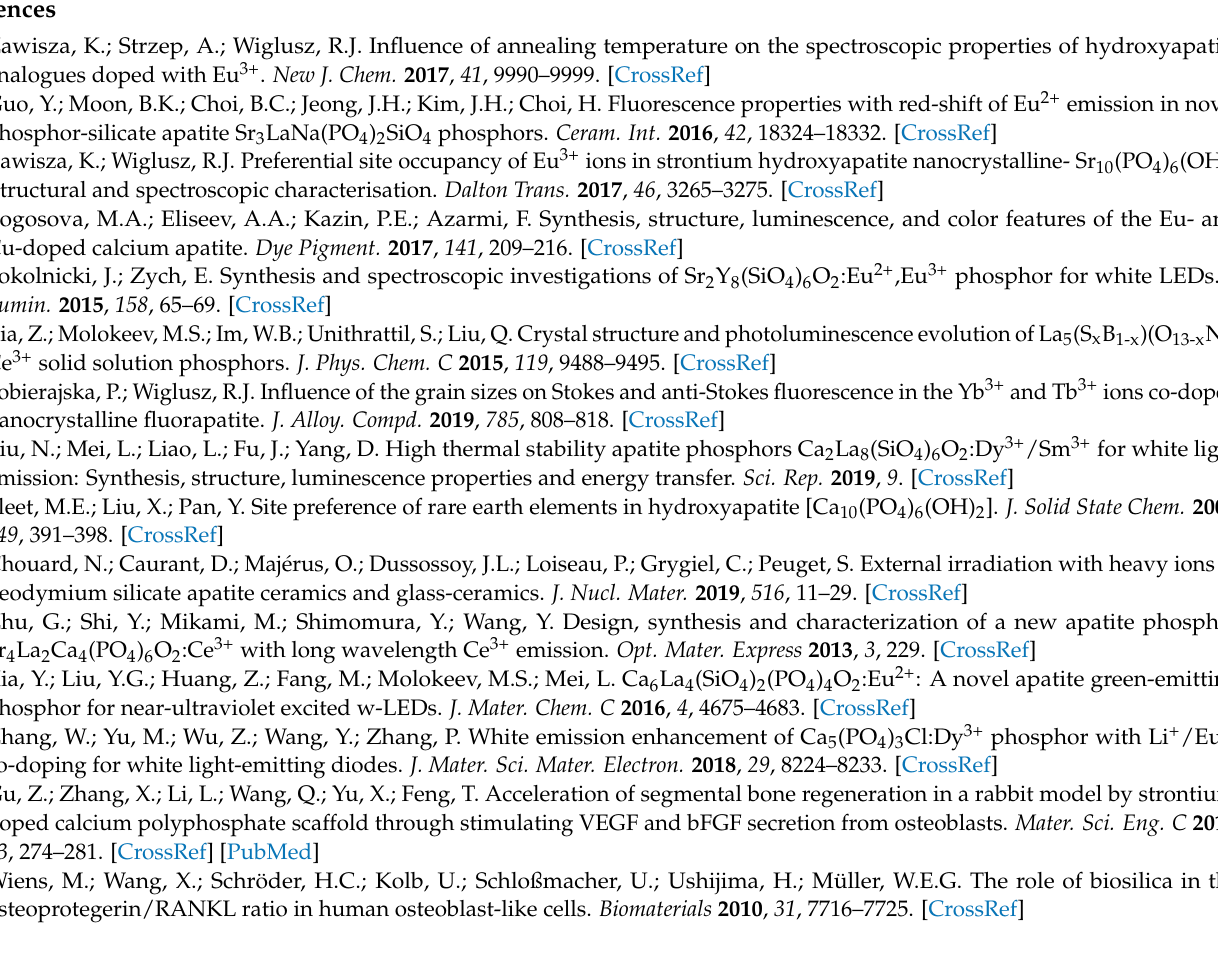
(SiO 4 ) 4 (OH) 2 , obtained at 600 ◦ C, Rietveld analysis (red—fitted diffraction; blue—differential pattern; column—reference phase peak position). Figure S3: Temperature-dependent emission intensity of the lines correspond to the listed transitions. Table S1. The amount of substrates used for synthesis of silicate-substituted hydroxyapatite co-doped wth Eu 3+ and Sr 2+ . Table S2: Unit cell parameters (a,c), cell volume (V), grain size as well as refine factor (R W ) for the Ca 10 (PO 4 ) 2 (SiO 4 ) 4 (OH) 2 co-doped with 2 mol% Sr 2+ and x mol/% Eu 3+ ions (where x = 0.5–2). Table S3: The comparison of the CIE color coordinates (x,y) of Ca 9.6 Sr 0.2 Eu 0.2 (PO 4 ) 2 (SiO 4 ) 4 (OH) 2 as a function of ambient